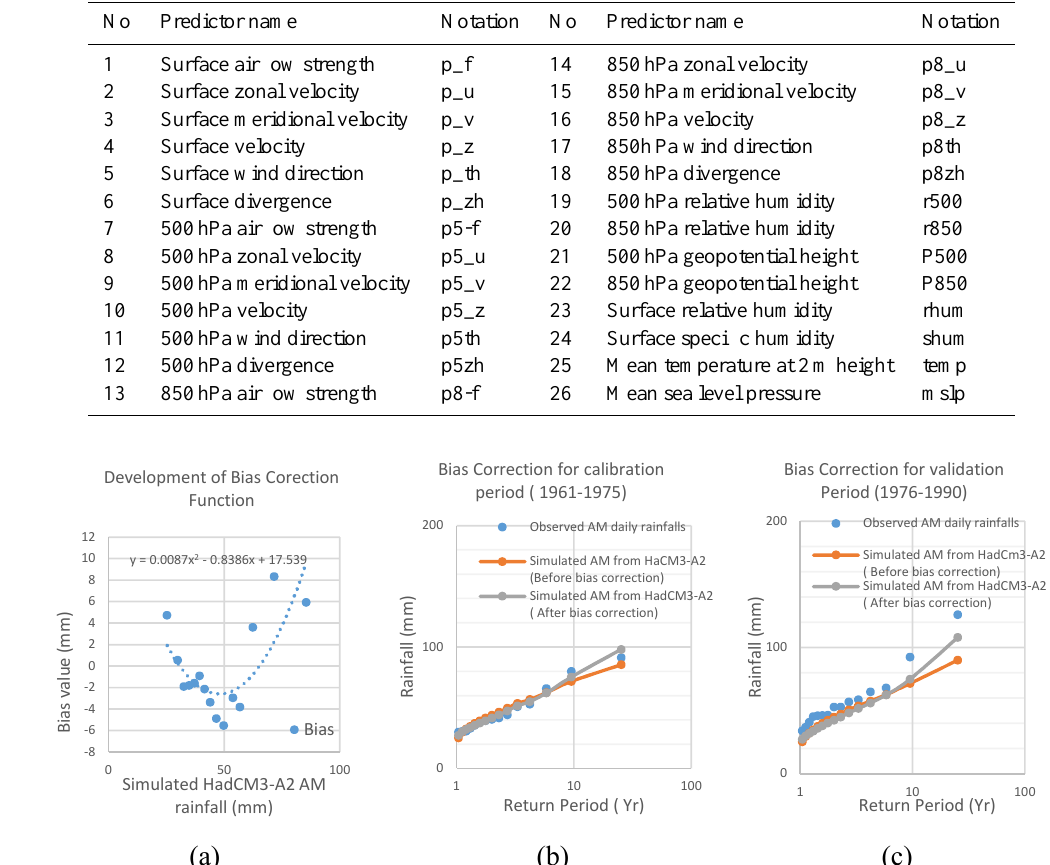
Table 2. NCEP reanalysis climate variable for HadCM3.